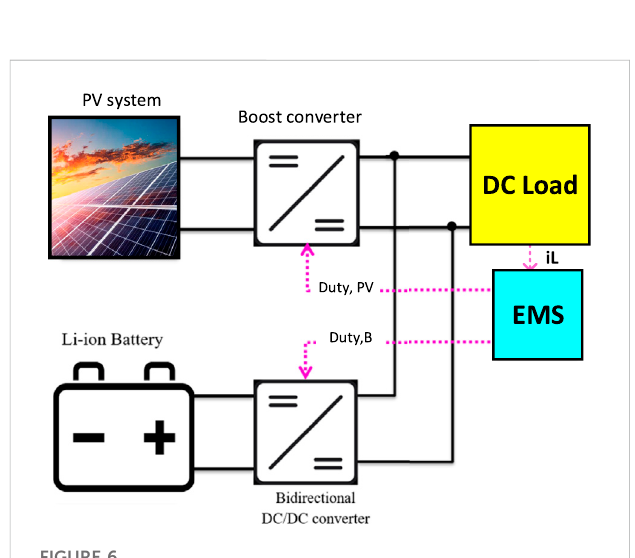
FIGURE 6 The proposed hybrid PV-battery power